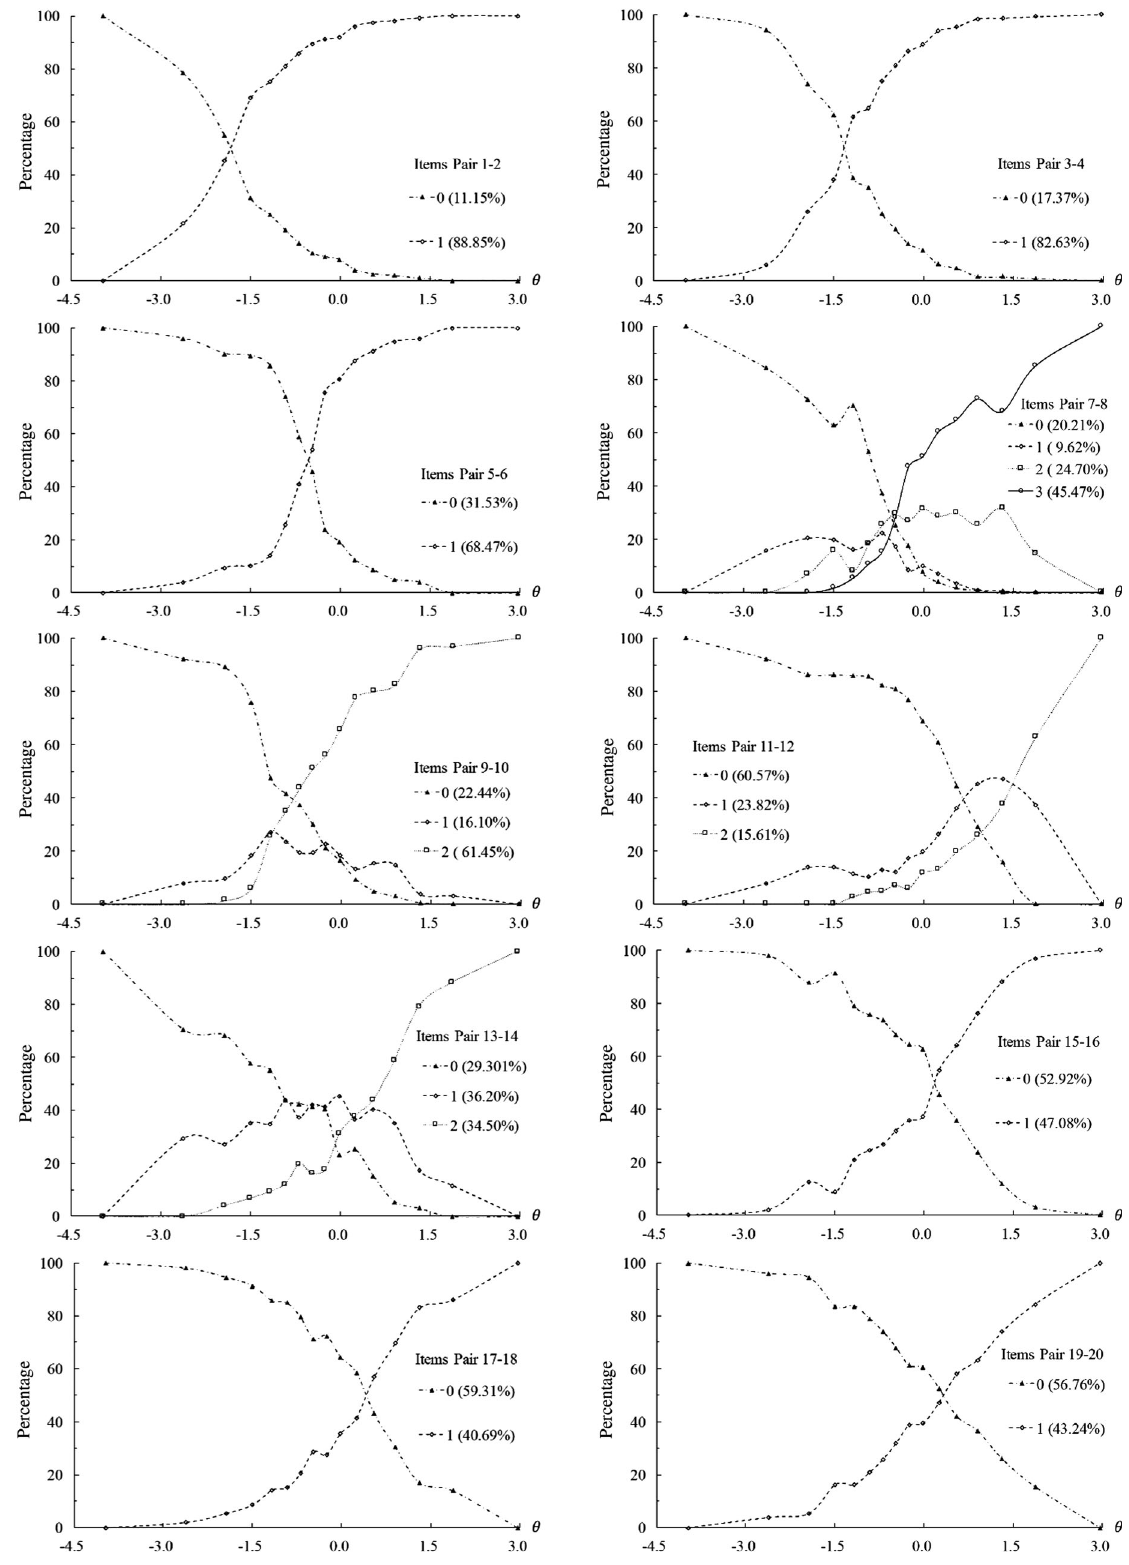
FIG. 4. Item response curves (IRCs) of S2 obtained with the new mixed Rasch